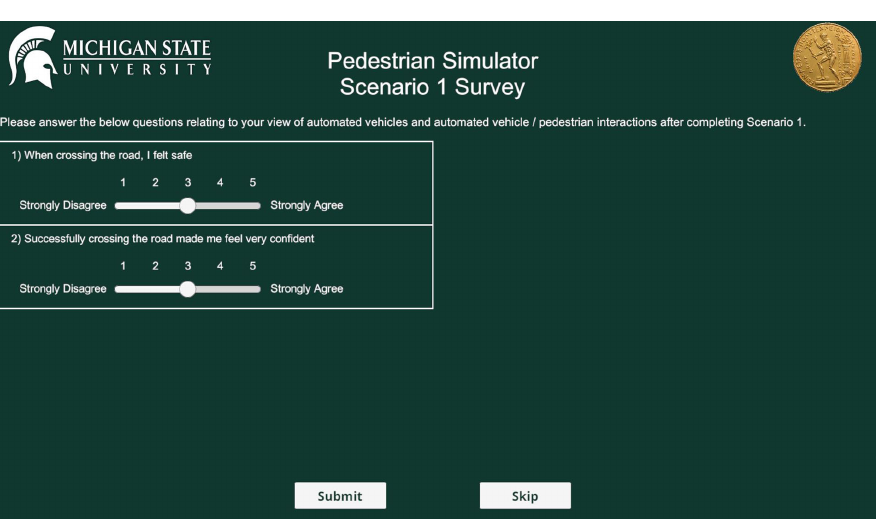
Figure 3. This survey appears after a user completes the first scenario.